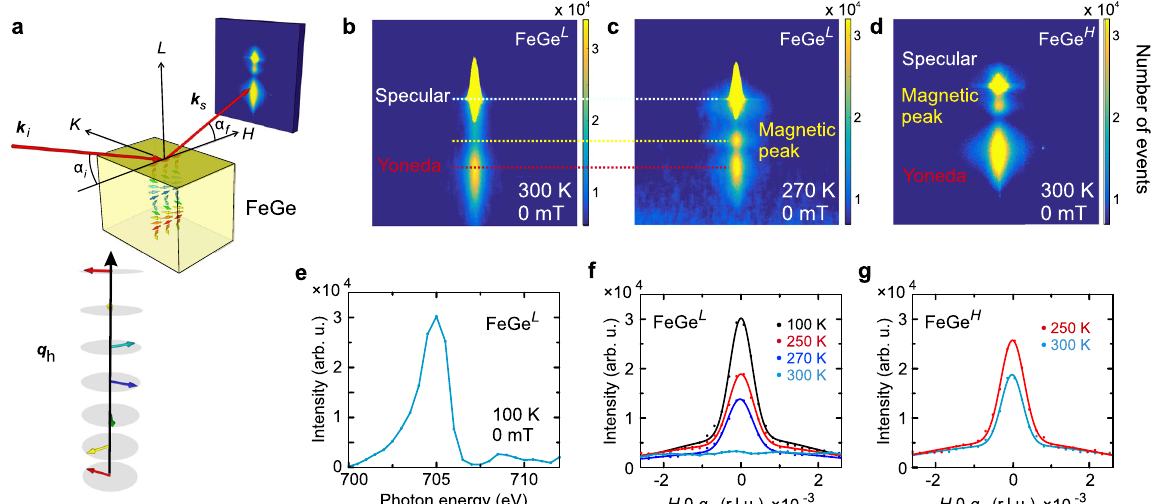
Figure 2. Resonant elastic x-ray scattering on FeGe films. ( a ) Illustration of the scattering geometry. The incident (scattered) x-ray wave vectors are labelled as k i ( k s ), and the corresponding incident (outgoing) angle as α i ( α f ). The photon energy is tuned to 705 eV near the Fe L 3 edge. If q h is along the FeGe film normal, a magnetic peak at (0, 0, q h ) is expected, however, this requires small incident angles. ( b , c ) CCD images showing the magnetic contrast at 300 K and 270 K, at zero applied magnetic field for a FeGe L film, with α i = 2.1°. The specular reflectivity, Yoneda, and magnetics peaks are labelled. Note that the magnetic peak does not fulfil the perfect diffraction condition at this incident angle, therefore it is detached from the specular peak. Further data processing reveals that this peak corresponds to q h = L = 0.0063 r.l.u. ( d ) CCD image showing the magnetic (0, 0,